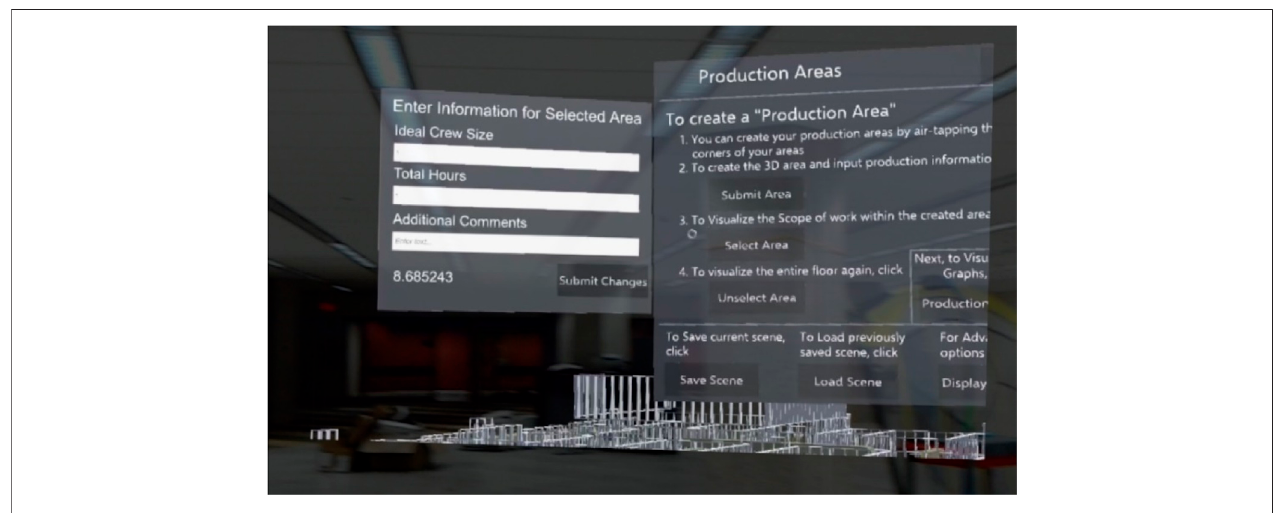
FIGURE 6 | Input production information related to the created production area.